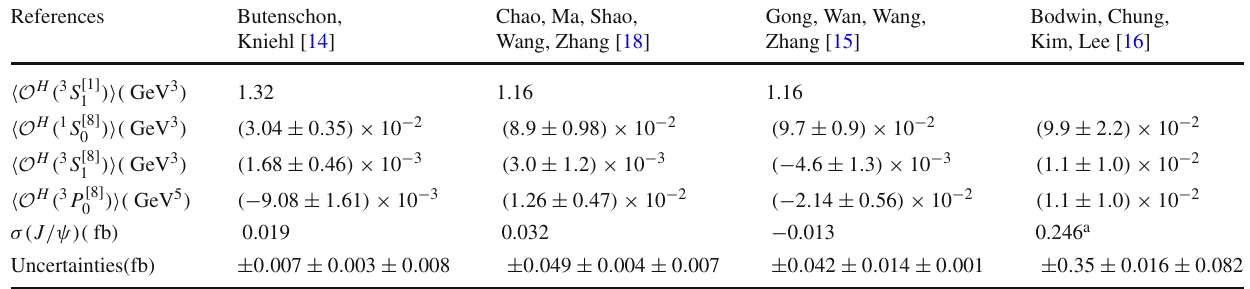
Table 4 The total cross sections for the double J /ψ inclusive produc- tion in e + e − annihilation at B-factory energy employing different sets of the LDMEs. The values of the LDMEs are taken from Refs. [14–